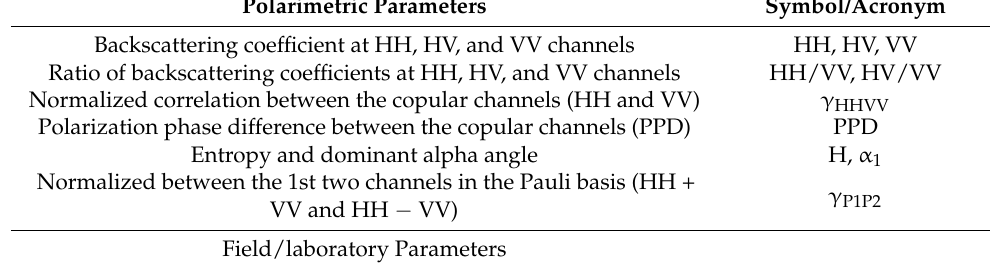
Table 2. List of polarimetric parameters derived from RADARSAT-2, field/laboratory estimations, and weather records used in this study. Polarimetric Parameters Symbol/Acronym Backscattering coefficient at HH, HV, and VV channels HH, HV, VV Ratio of backscattering coefficients at HH, HV, and VV channels HH/VV, HV/VV Normalized correlation between the copular channels (HH and VV) γ HHVV Polarization phase difference between the copular channels (PPD) PPD Entropy and dominant alpha angle H, α 1 Normalized between the 1st two channels in the Pauli basis (HH + γ P1P2 VV and HH − VV) Field/laboratory Parameters Height Fraction of Vegetation Cover FVC Leaf Area Index LAI Fresh Biomass Percentage of Water Content PWC Soil Moisture SM Weather Records Precipitation P Evapotranspiration ET0 Temperature